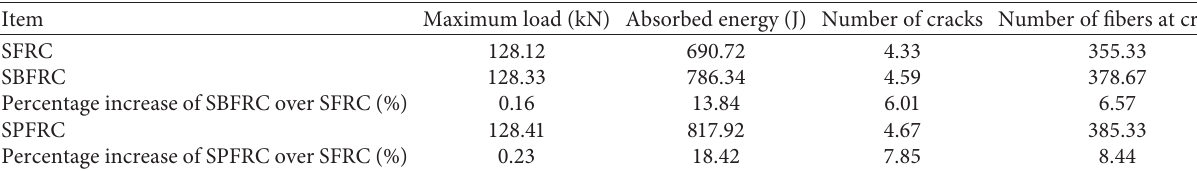
Table 4: Results of energy toughness test of large plate.